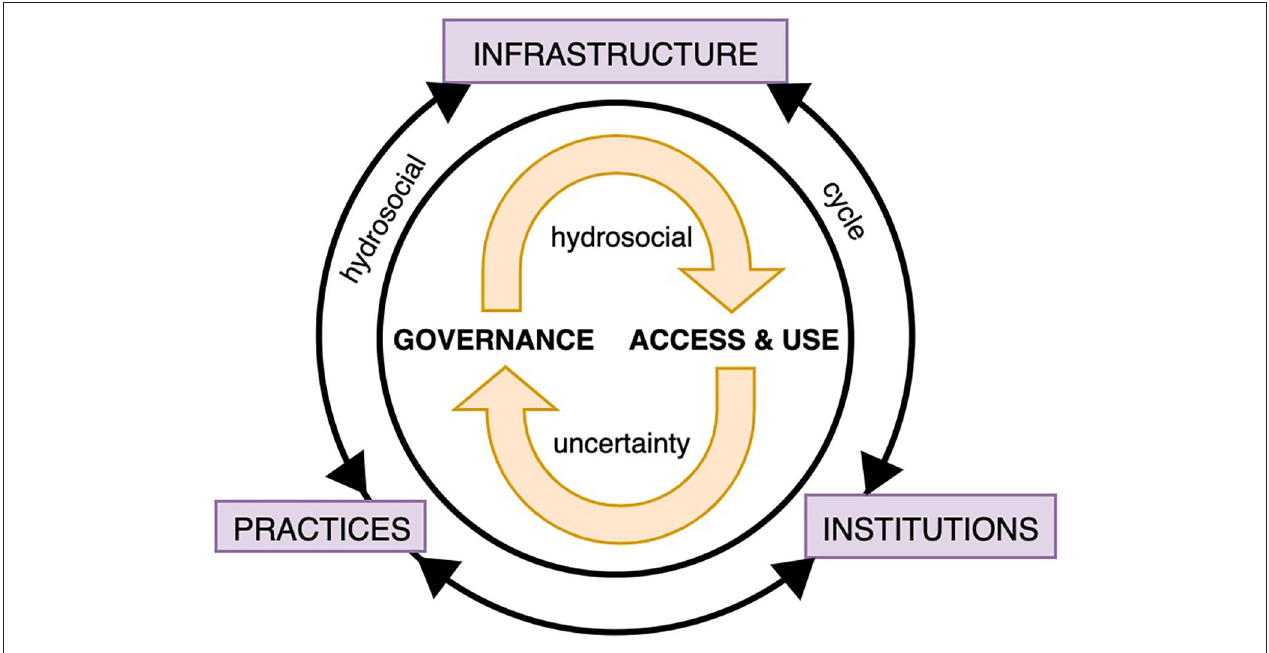
FIGURE 1 | The production of hydrosocial